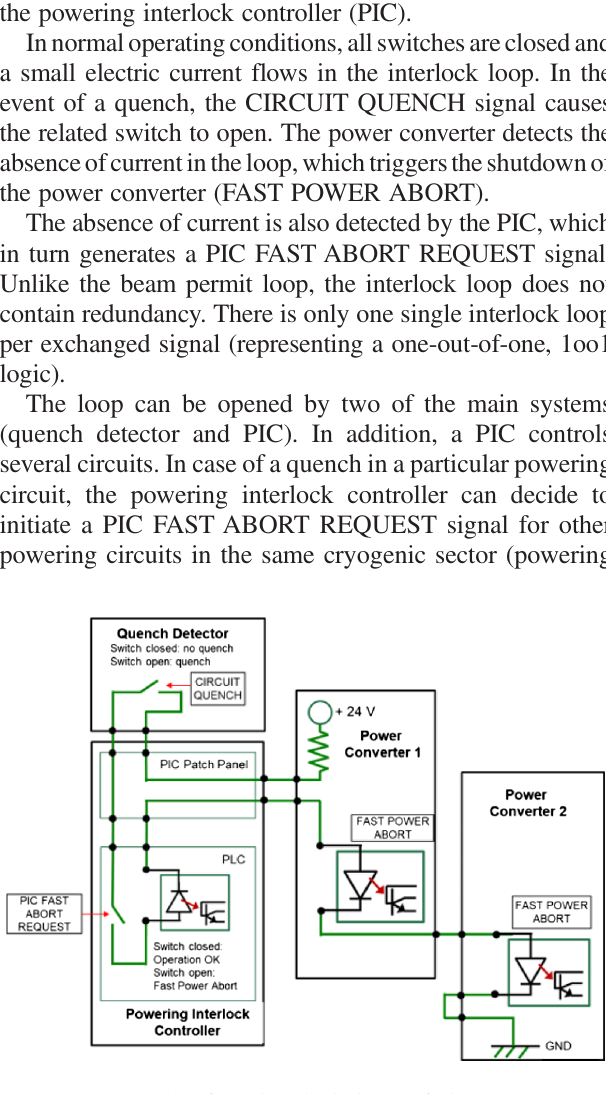
FIG. 4. Example of an interlock loop of the LHC magnet powering system with powering interlock controller